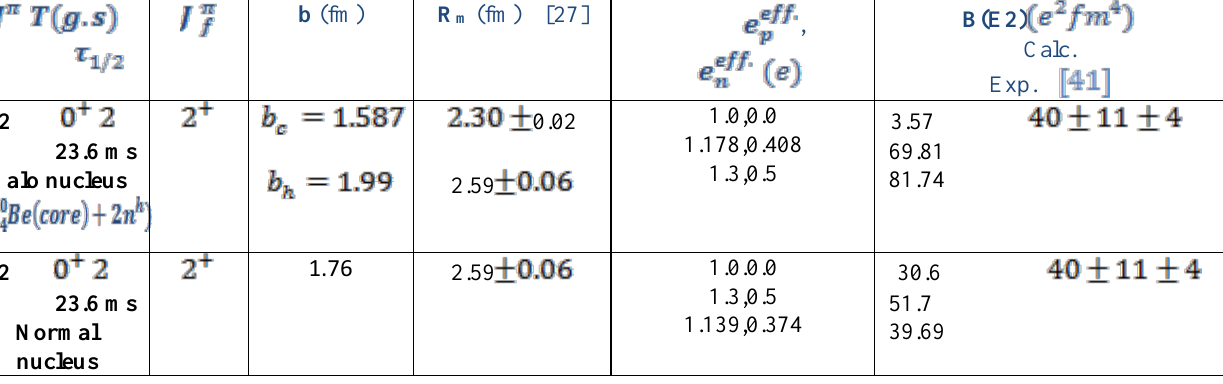
Table 3: The calculated effective charges and B(E2) values of 12 Be compared with the experimental data.